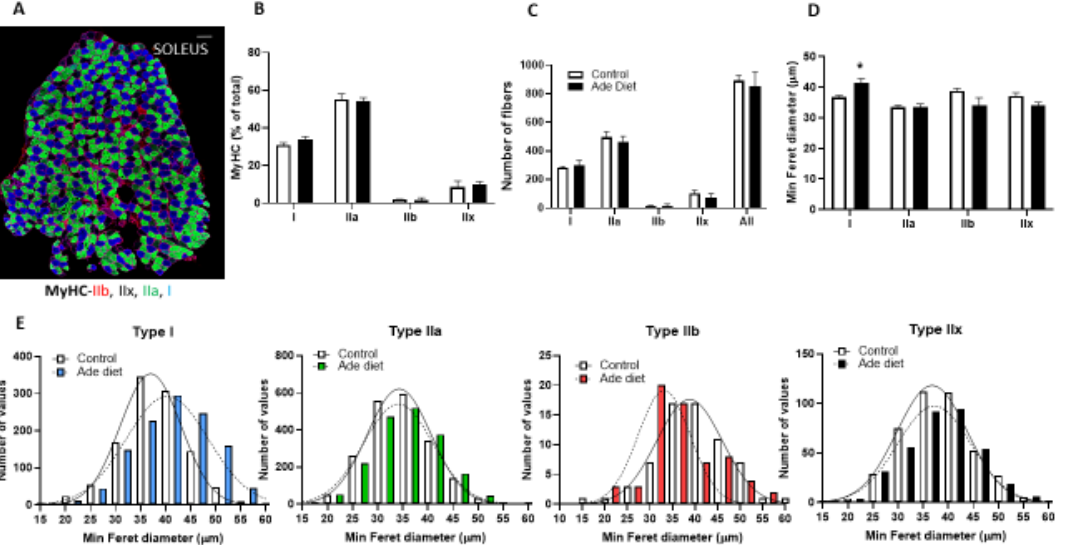
Figure 3. Soleus muscle fiber characteristics in mice with kidney disease. Mice were exposed to a 0.2% adenine-containing diet to induce kidney disease. Muscle fiber composition and structure were compared between mice that were exposed to adenine versus control diet. ( A ) Representative photograph of Soleus muscle MyHC staining in control mice (Scale bar = 100 microns). ( B )